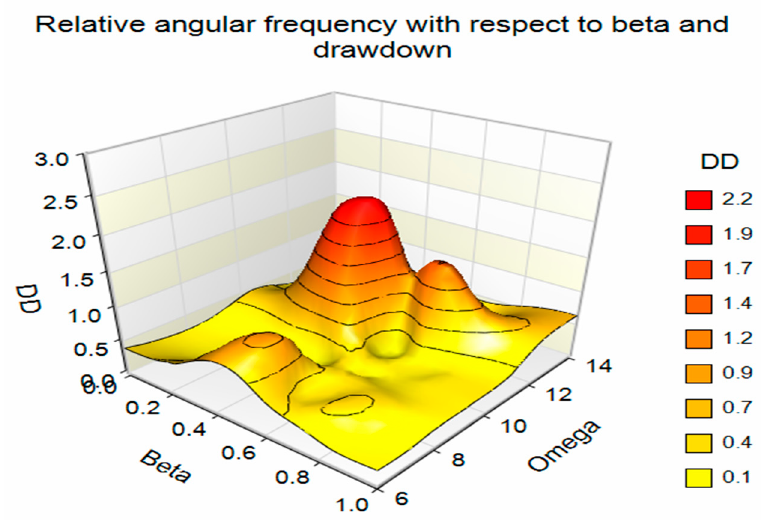
Figure 1. Depiction of drawdown (DD) with respect to the growth ( β ) and frequency ( ω ) of the same t.